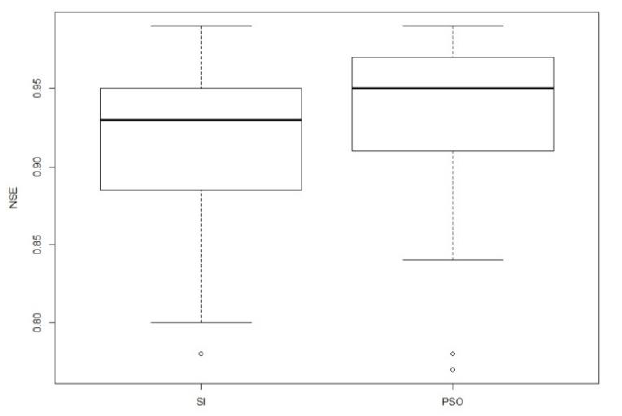
Figure 9. Boxplot of fit goodness from IS and PSO parameterization methods.